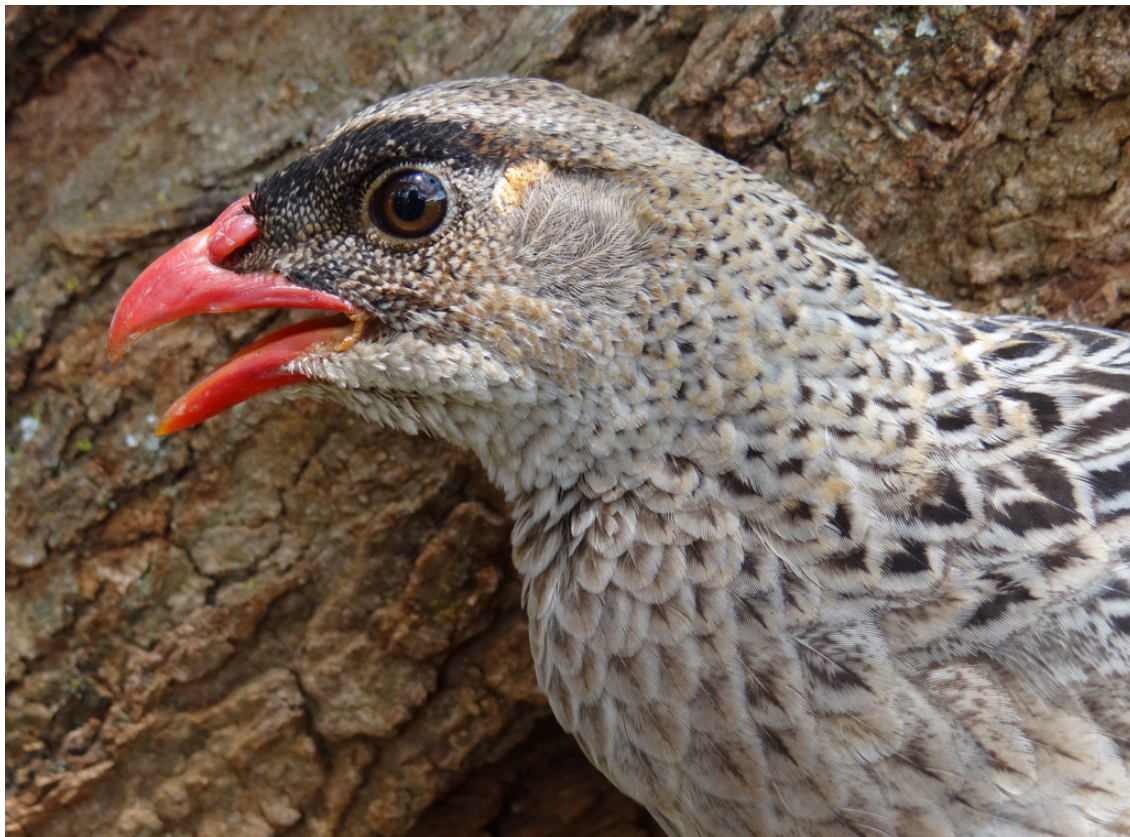
Fig. 4. The Black-fronted Francolin Pternistis castaneicollis atrifrons (Conover, 1930) exists in a small mountain range around Mega in southern Oromia (Borana zone). It shows a number of distinct features that may justify the split from P. castaneicollis (Photo: Kai